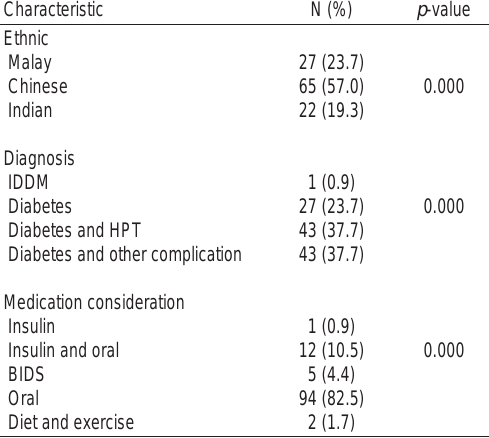
TABLE 8. Characteristic determination of RF6-Female > 55 years (N=90/147) among female in study population Characteristic